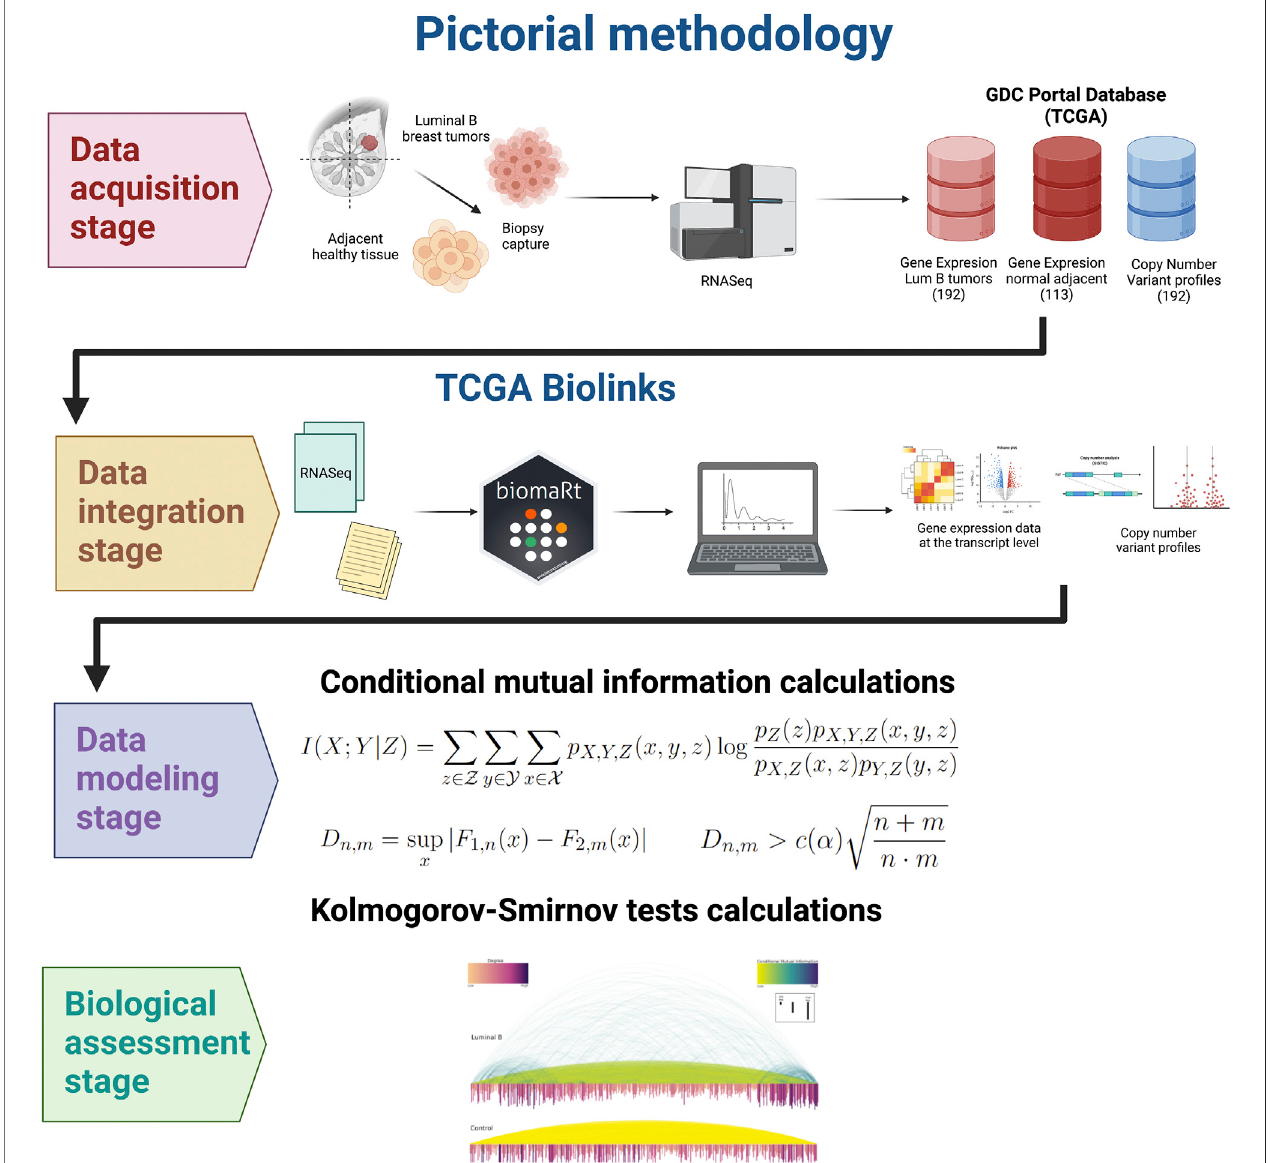
FIGURE 1 | Work fl ow of this study. RNASeq obtained from tumor and control adjacent tissue biopsies (coming from the TCGA/GDC collaboration database) serves asabasisfor conditional co-expressionand CNV analysis.Sampleswerepre-processedforquality controland normalization, batcheffectremoval and mlti-level noise reduction. Copy number variation and RNA expression data were used to perform the conditional mutal information, Finally, spatial co-expression analysis was implemented.